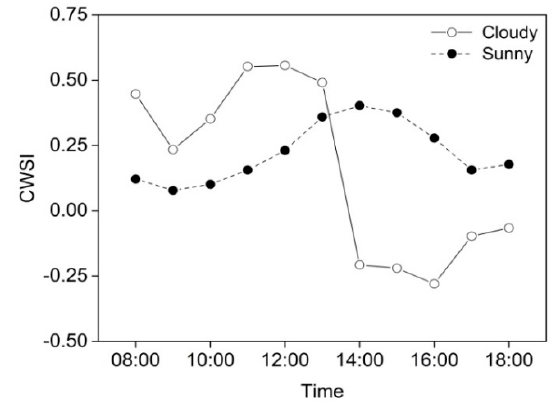
ff erent weather